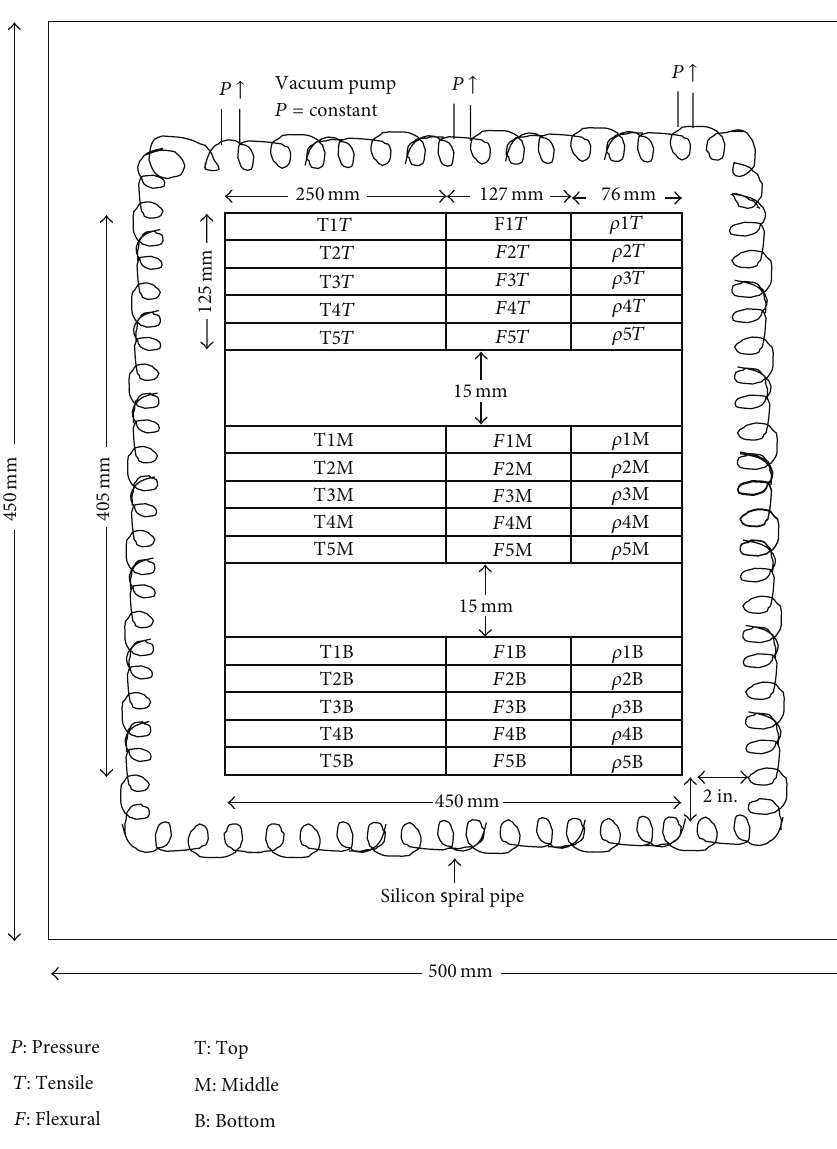
Figure 9: Estimated dimension for the composite